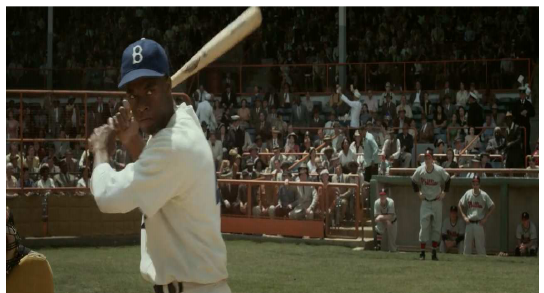
Figure 1: Representation of Jack Robinson who was up to bat when receiving White’s racial abuse by Ben Chapman (Philadelphia Phillies’ coach) towards Jack Robinson. Source: 42 (2013)